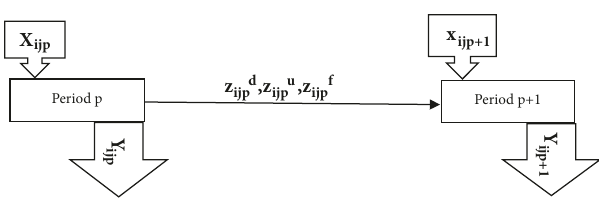
Figure 1: Representation of the proposed dynamic DEA.